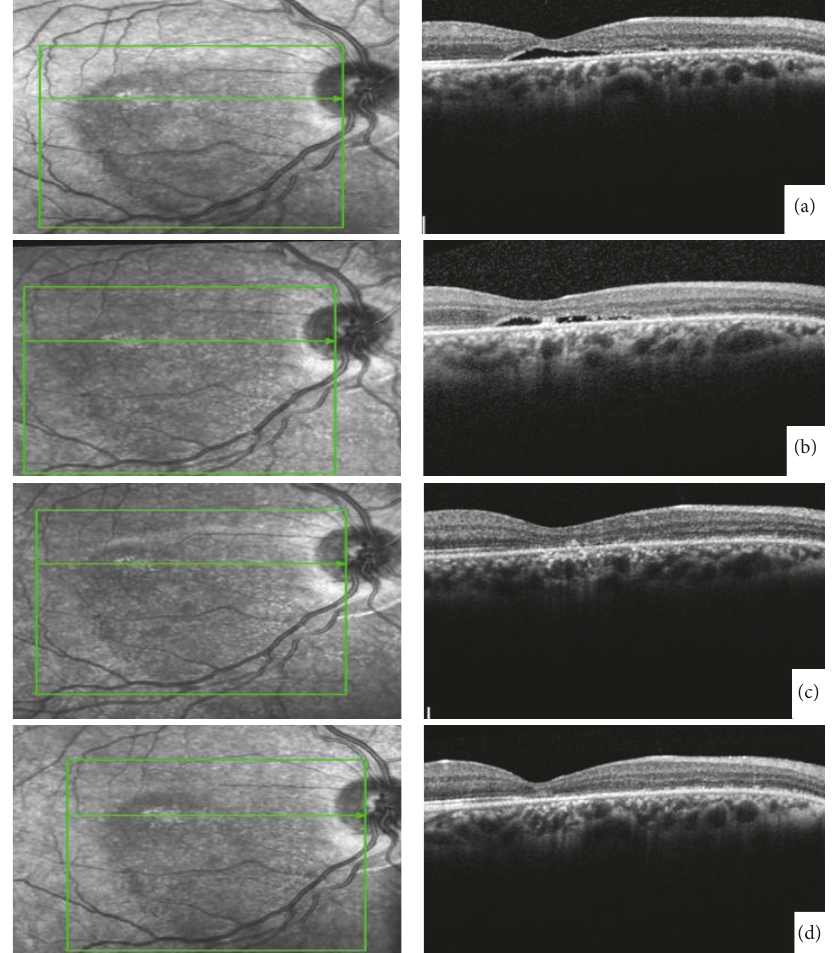
Figure 4: Spectral-Domain Optical Coherence Tomography (SD-OCT) progression demonstrating resolution of the macular hole (MH) and regeneration of outer retinal layers one (a), two (b), three (c), and five months’ (d) status after pneumatic displacement and t-PA intravitreal